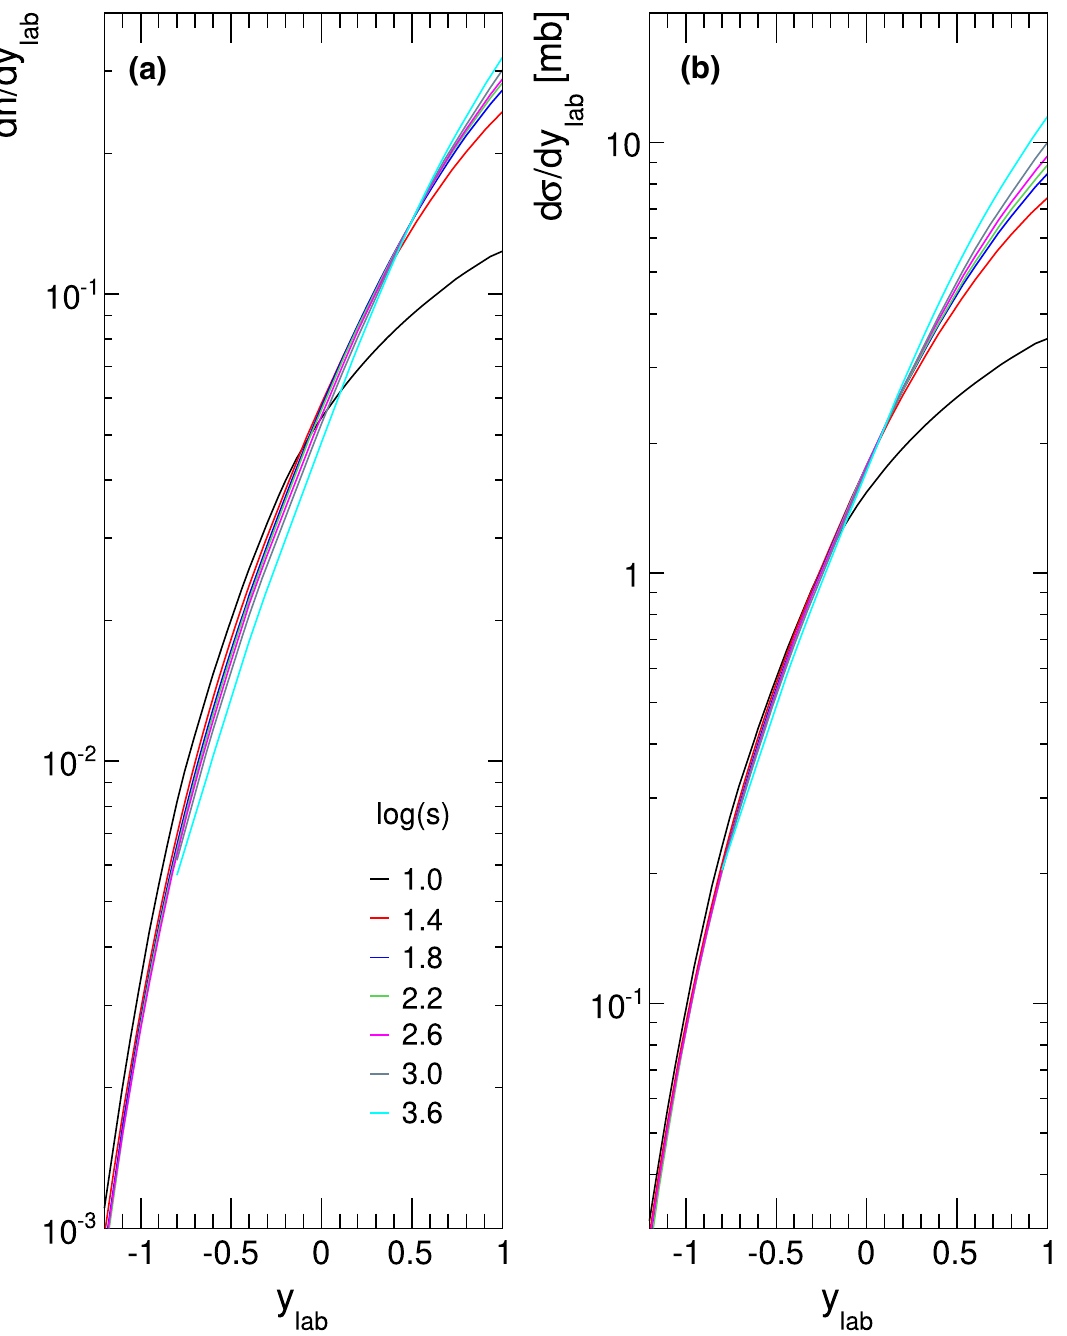
Fig. 148 y lab distributions of (a) the rapidity density per inelastic event and (b) the integrated invariant cross section as a function of y lab for seven values of log ( s ) extent of the longitudinal phase space with energy